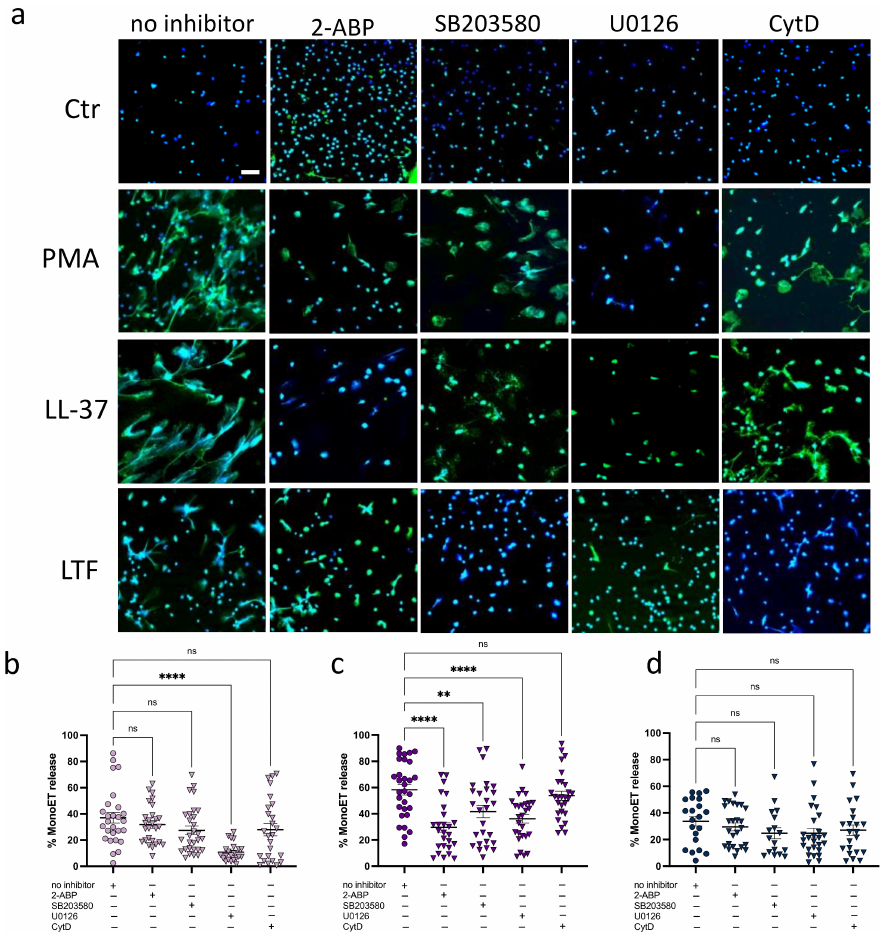
Figure 3. Different stimuli engage various pathways in ET formation. ( a ). Representative fluores- cence microscopy images of CD14+ monocytes incubated with PMA, LL-37, or LTF. Blue = DAPI, Green = Histone-DNA complex. Scale bar is 50 µ m. ( b – d ). Quantitative analysis of CD14+ monocytes pre-incubated with inhibitors of different pathways (SOCE, MAPK, ERK1/2, actin rearrangement) and stimulated with ( b ) 25 nM PMA, ( c ) 5 µ M LL-37, or ( d ) 75 nM LTF. All data represent mean +/– SEM of 6 independent experiments. ns = not significant, ** p ≤ 0.01, **** p ≤